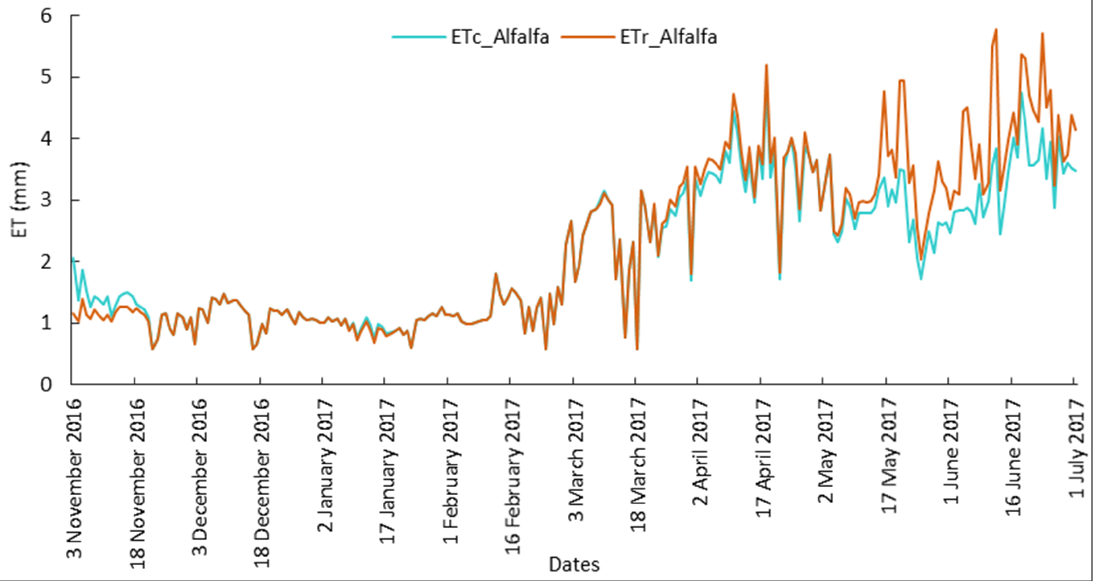
Figure 15. Comparison between ETc and ETr for alfalfa crops